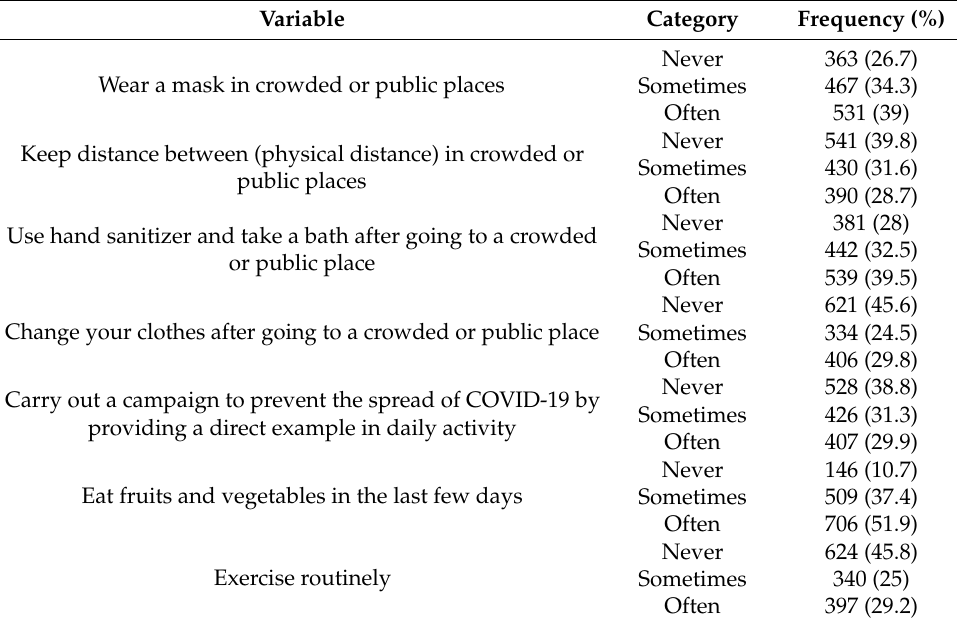
Table 6. COVID-19 prevention practices at the time of the COVID-19 vaccine hesitancy surveys, Ethiopia,